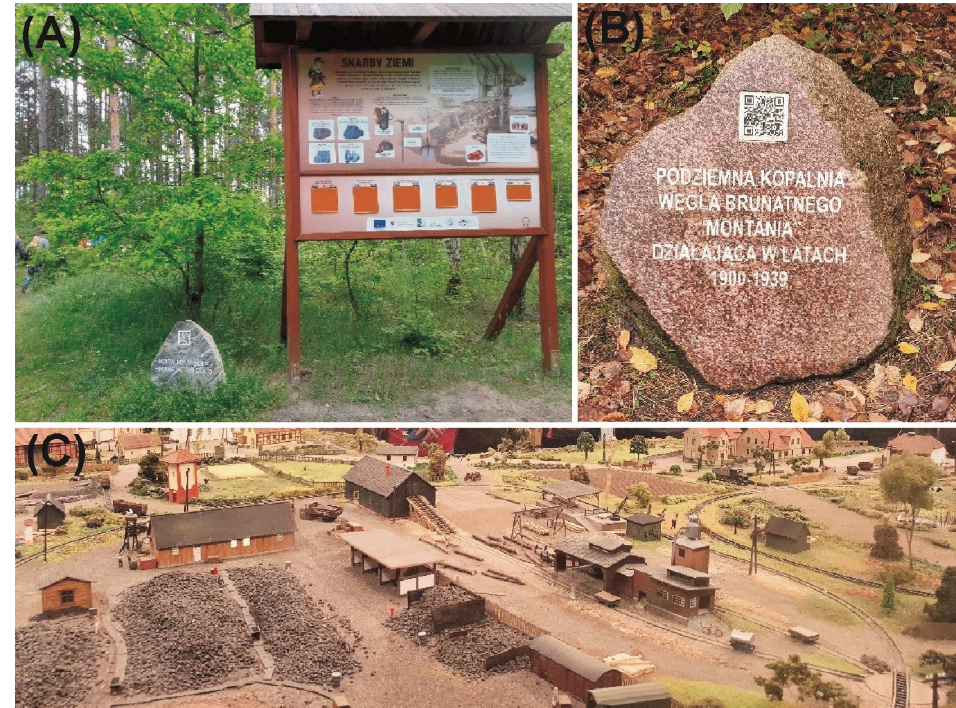
Figure 5. Mining relicts after the „Montania” mine. ( A )—coal washing tanks, ( B )—dip heading.